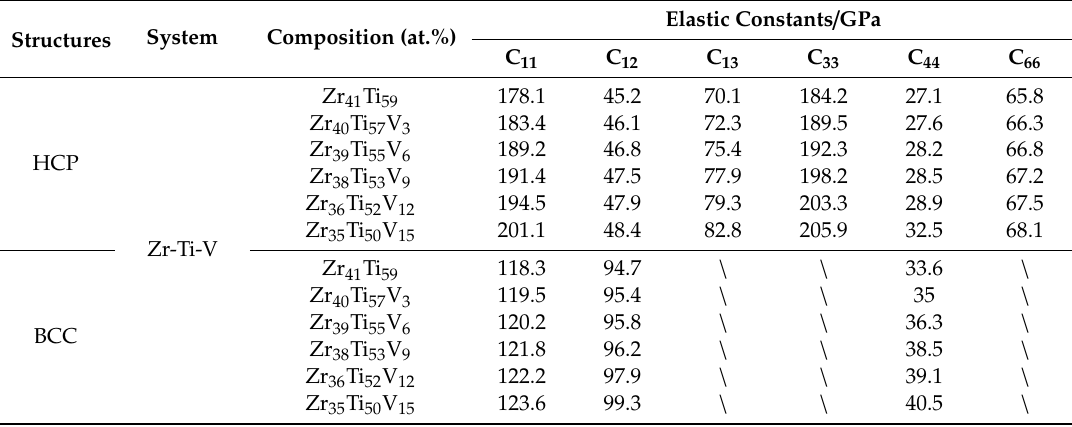
Table 8. Independent elastic constants of HCP structure and BCC structure Zr-Ti-V alloy systems. Structures System Composition